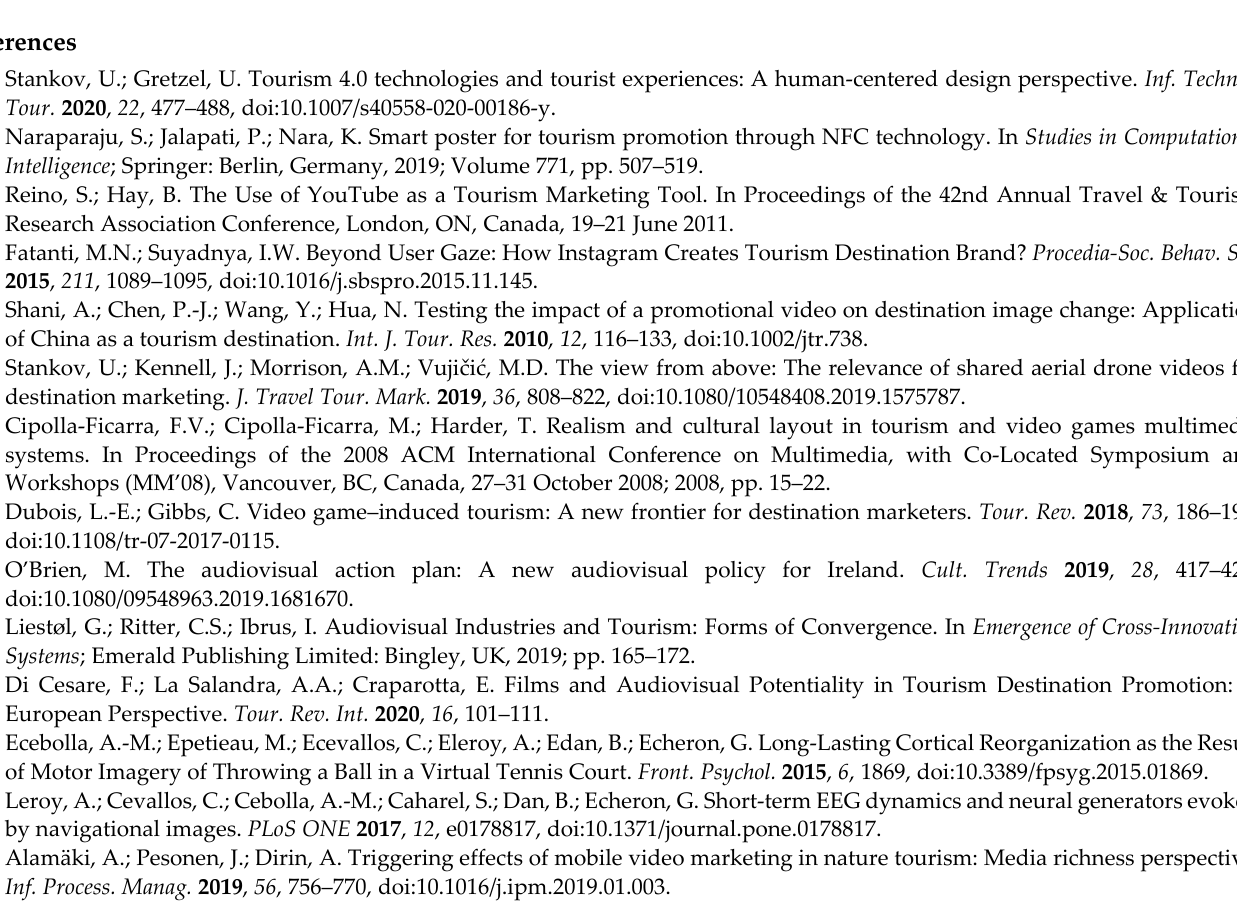
Figure A2. Relation between microstates of video 2. The figure shows each relation between mi- crostates, their time lapse in the record and how many relations